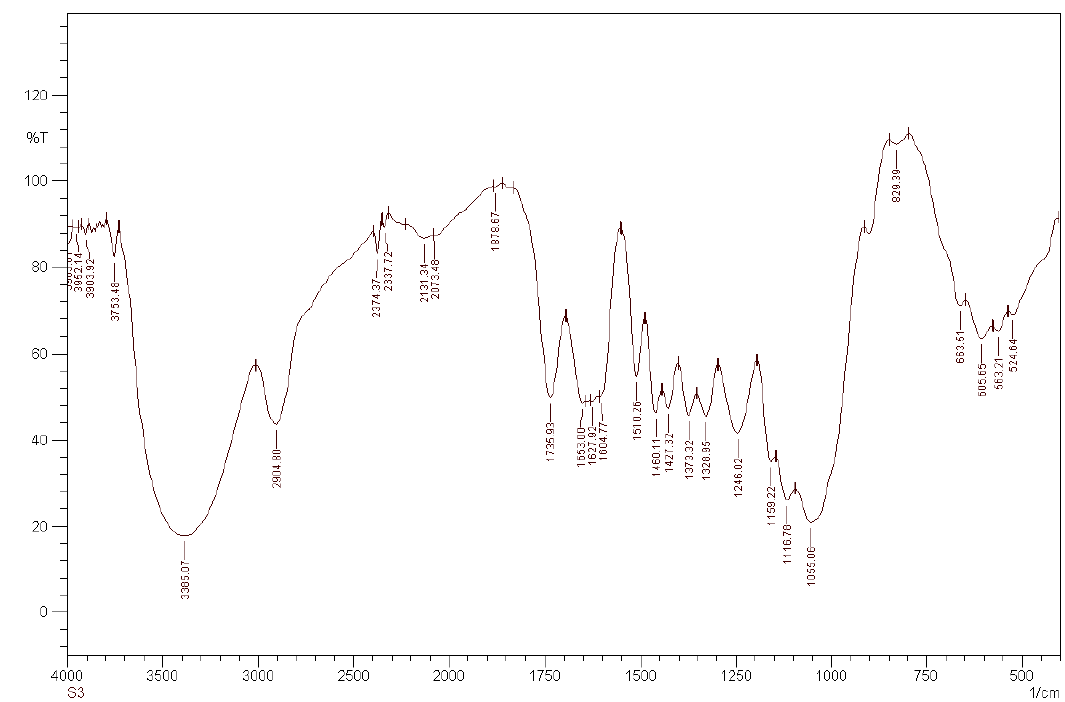
Figure 1. Transmittance spectrum of Rhizophora spp. particleboard bonded with 0% binder.